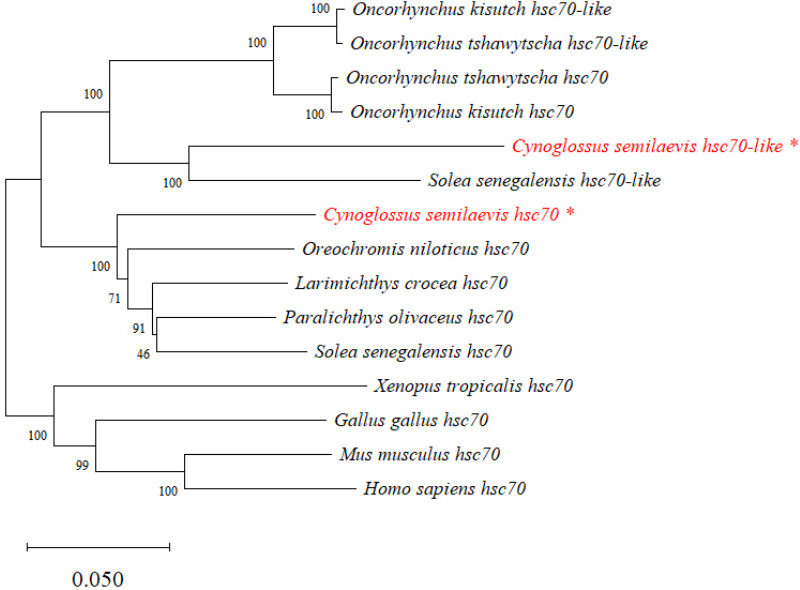
Figure 3. Phylogenetic tree of target genes. The tree was constructed using nucleic acid sequences of hsc70 and hsc70-like from different species using the neighbor joining method with 1000 bootstrap replicates. Numbers at nodes indicated bootstrap support. C. semilaevis hsc70 and hsc70-like genes were red and labelled with asterisk (*).